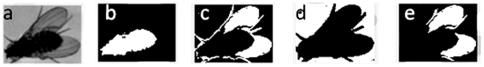
(a) The original gray image. (b), (c), and (d) are the patch of the body, wings, and background, respectively. (e) The clear wing patch after morphological operation.